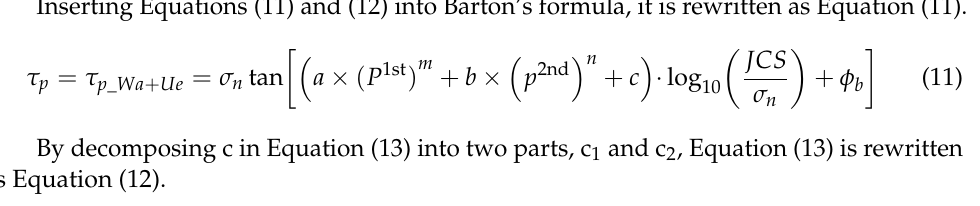
/ Z 2nd , ( b ) K W − U VS . ( R 1st 2 2